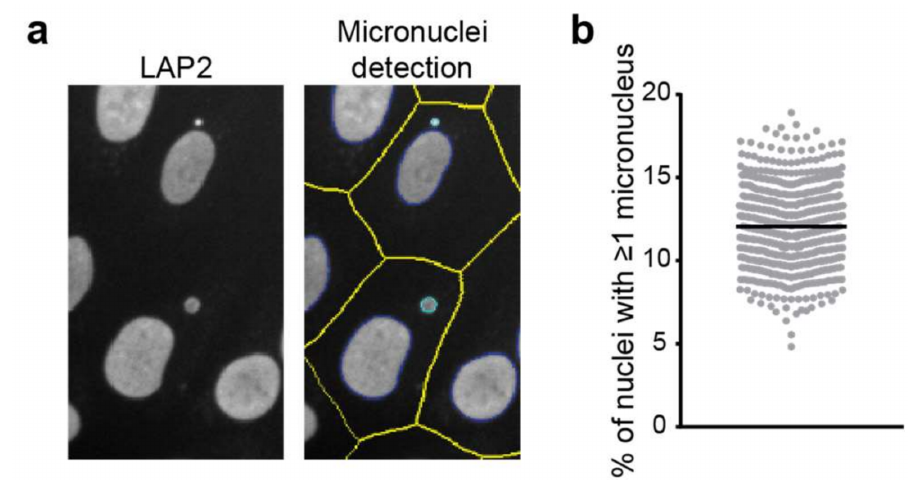
Figure 3. Detection of micronuclei in LAP2-stained images acquired on a high-content microscope. ( a ) Example of micronuclei detection in automated microscopy. Defined nuclear contours are indi- cated in dark blue, micronuclei in cyan and cell boundaries in yellow. See details of the analysis in the main text. ( b ) Quantitation of micronuclei frequency on images acquired on a high-content microscope in hTERT immortalised control fibroblasts in multiple biological